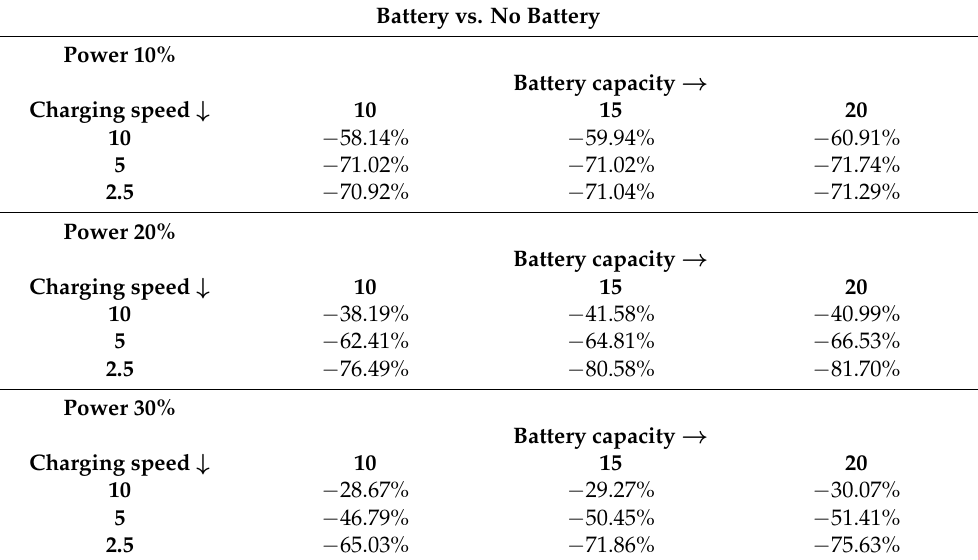
Table A1. Energy used over the peak power.